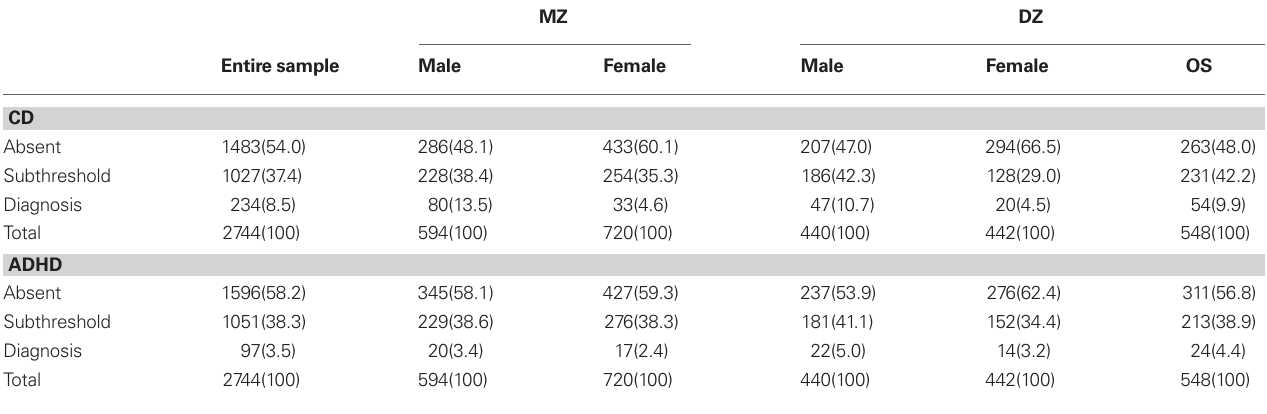
Table 1 | Number of individuals (and percentages of sample) with no CD/ADHD symptoms, subthreshold CD/ADHD symptoms, and diagnosis of